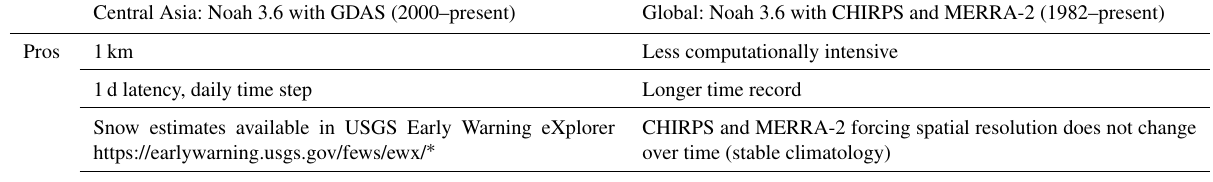
Table 3. Pros and cons of the two data streams. Central Asia: Noah 3.6 with GDAS (2000–present) Global: Noah 3.6 with CHIRPS and MERRA-2 (1982–present) Less computationally